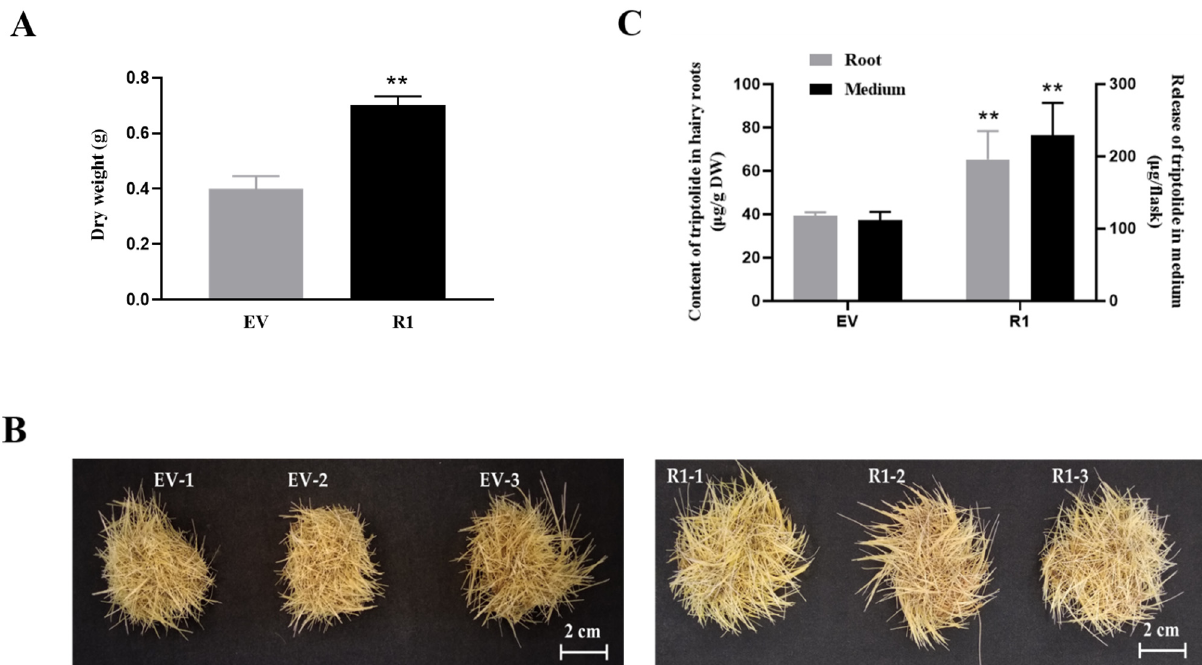
Figure 5. The biomass, phenotypes, and the production of triptolide in the control (EV) and TwMYC2a/b RNAi (R1) hairy roots lines. ( A ) The dry weight of the control (EV) and R1 hairy roots. ( B ) Phenotypes of the control (EV) and R1 hairy roots. Scale bars are 2 cm. ( C ) Triptolide content in hairy roots and the release content of triptolide in the medium in the control (EV) and R1. DW, dry weight. All the hairy roots were obtained after being cultured for 28 d. All data presented here are means ± SD of three biological replicates. Statistical significance was determined by Student’s t -test (** p < 0.01). These assays were repeated three times with similar results.